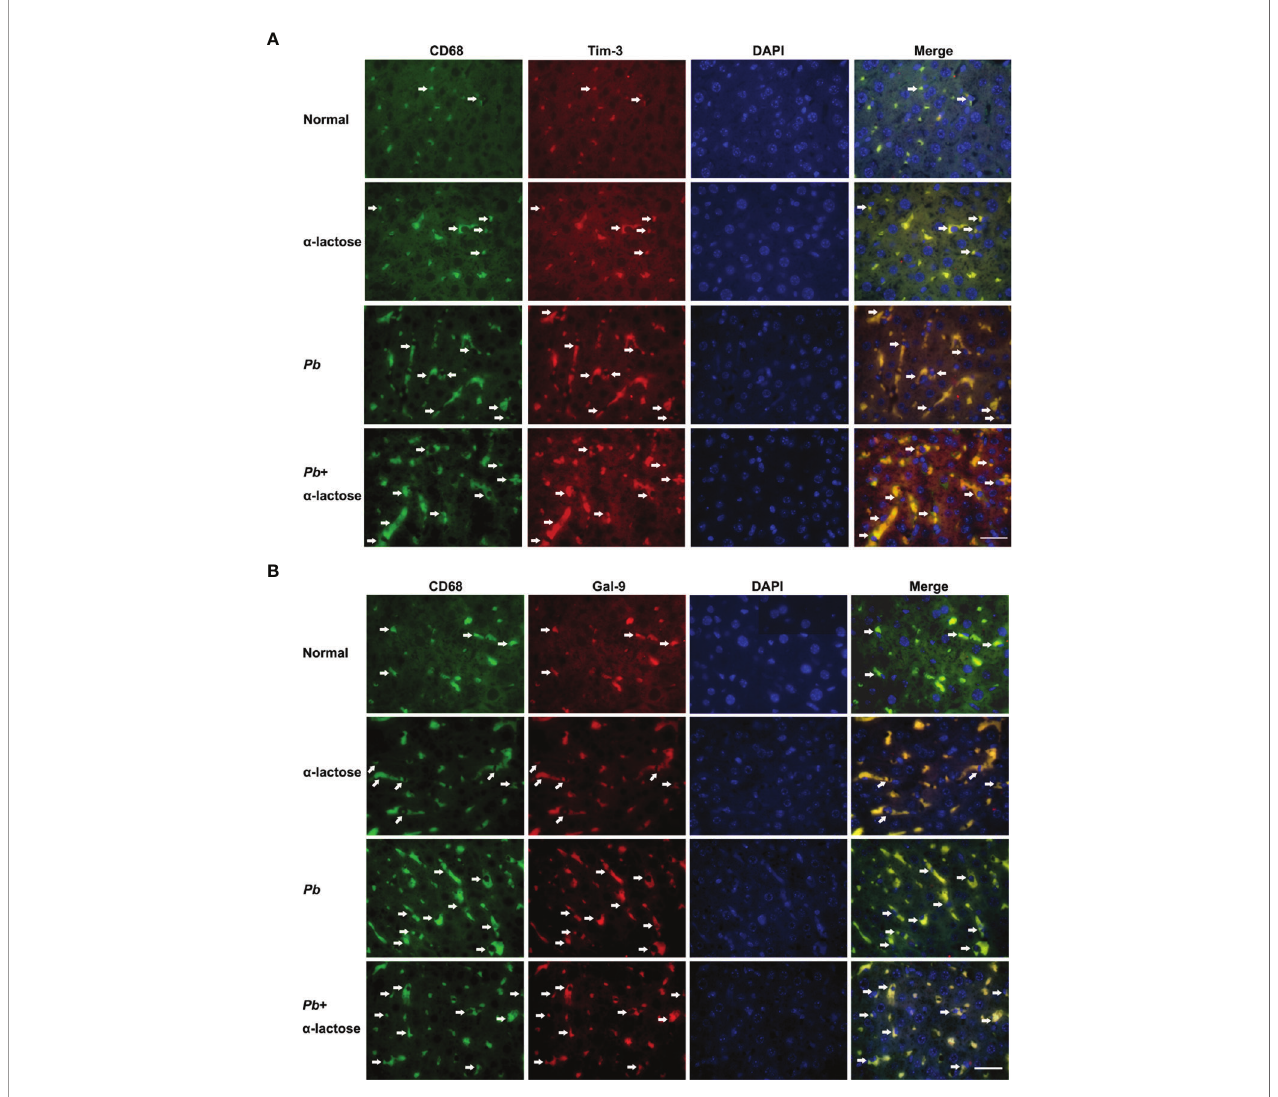
FIGURE 5 | Immuno fl uorescence staining for CD68 + -Gal-9 + and CD68 + -Tim-3 + macrophages in the liver tissues of Pb ANKA-infected mice with or without a -lactose treatment. Double immuno fl uorescence showed expression of Gal-9 or Tim-3 on CD68 + macrophages. (A) CD68 + -Gal-9 + macrophages in the liver tissues of malarial mice and malarial mice with a -lactose treatment on day 7 p.i. (B) CD68 + -Tim-3 + macrophages in the liver tissues of malarial mice and malarial mice with a -lactose treatment on day 7 p.i. in comparison of naive and a -lactose-control. Positive cells were indicated with white arrow heads. Original magni fi cation ×